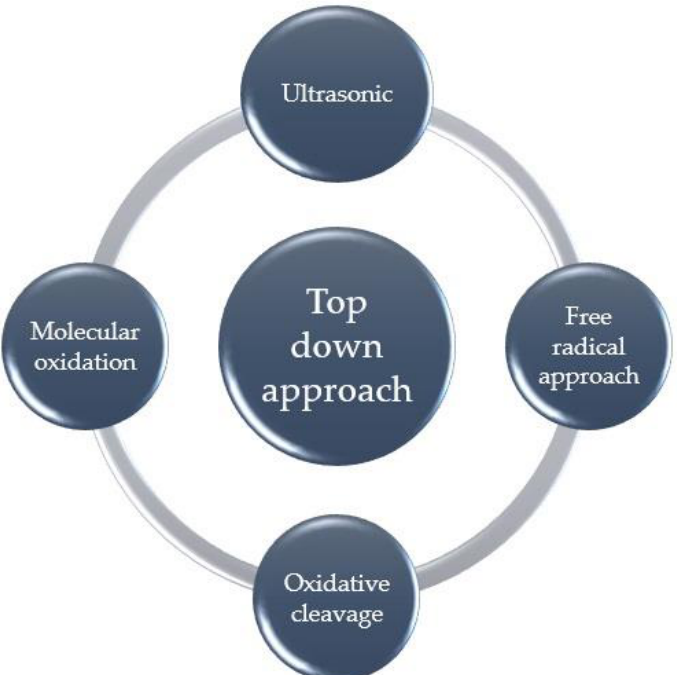
Figure 4. Schematic depicting the different techniques of the top-down approach used for the preparation of GQDs.